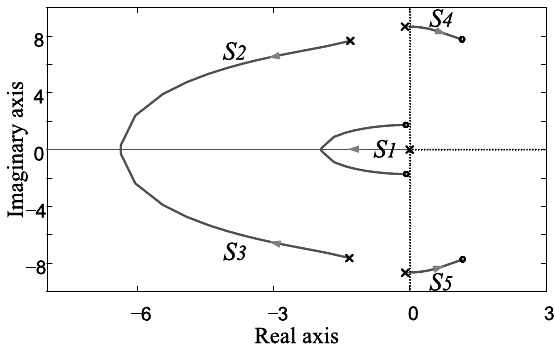
Figure 14. The root locus of D (s) following n 1 changes when n 2 = 0.002 V/var.